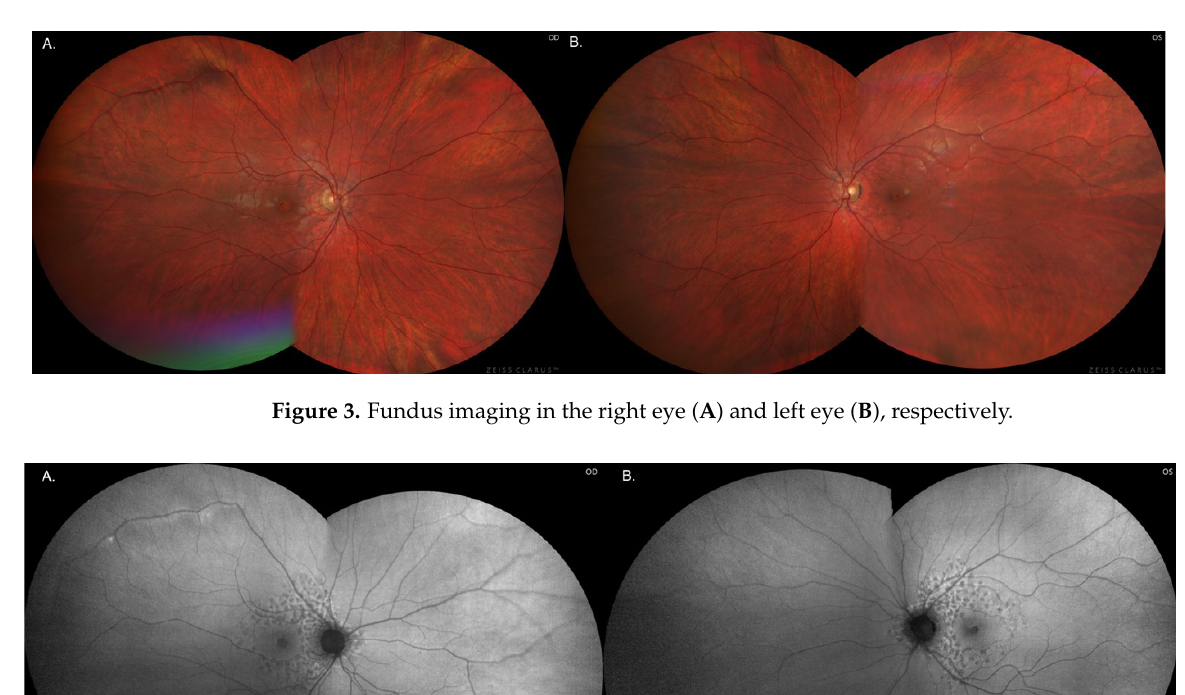
Figure 2. Correct recording in the OCT, RE ( A ) and LE ( B ); kinetic perimetry, RE ( C ) and LE ( D ); and Farnsworth D-15 tests, RE ( E ) and LE ( F ).